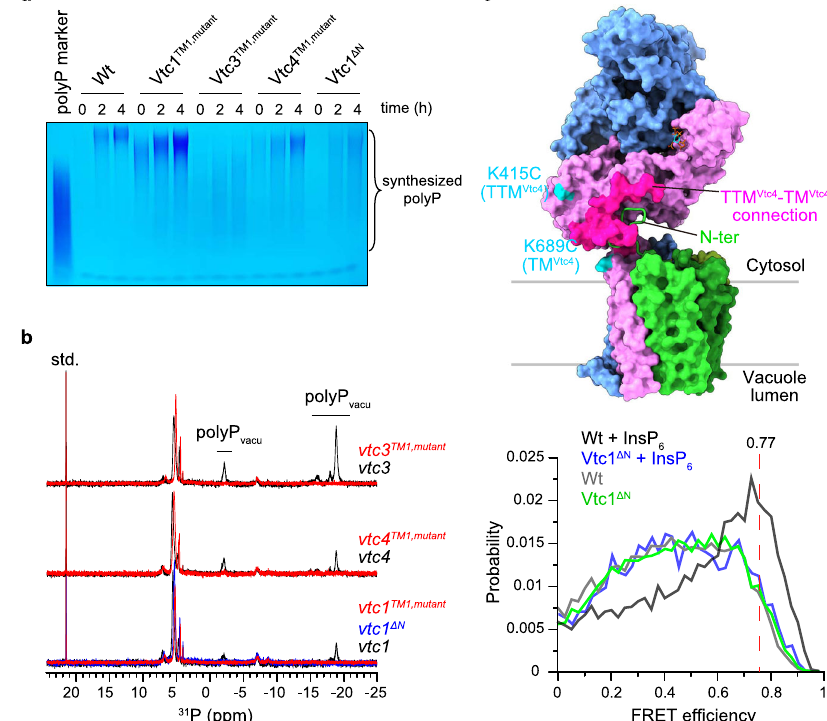
Fig. 5 | Mechanistic coupling of polyP synthesis and membrane translocation. vacuolarpolyParedenoted.MDPwasusedasthestd.reference. c smFRETanalysis a Assay of VTC-catalyzed polyP synthesis. 5 μ M protein complex were used and of VTC conformational changes. Top : Sites for fl uorophores conjugation are high- reactions were performed with required times in the presence of 1mM InsP 6 . Wt, lighted in cyan on the molecular surface representation of InsP 6 -activated VTC Vtc1/Vtc3/Vtc4; Vtc1 TM1,mutant , Vtc1 K24A/R31A /Vtc3/Vtc4; Vtc3 TM1,mutant , Vtc1/Vtc3 K694A/ complex. The connection between TTM Vtc4 and TM Vtc4 (residues 472 – 618) is Δ N ,Vtc1 Δ representedinmagentasurface.TheN-terminusofVtc1 A protomer(N-ter,residues 1 – 21 /Vtc3 K698A/R705A/R709A /Vtc4;Vtc4 TM1,mutant ,Vtc1/Vtc3/Vtc4 K622A/R629A ;Vtc1 /Vtc4. Source data are provided as a Source Data fi le. The experiments were 1 – 21)isshownincartoonrepresentation. Bottom :smFRETpro fi lesof VTCcomplex repeated three times independently with similar results. b In-cell 31 P-NMR mea- (Wt)inthe presenceand absenceof1mMInsP 6 are colored inblackandgraylines, surement of vacuolar polyP in yeast strains. vtc3 and vtc3 TM1,mutant , vtc4 and respectively. smFRET pro fi les of VTC complex carrying Vtc1 N-terminus deletion (Vtc1 Δ N ) in the presence and absence of 1mM InsP 6 are colored in blue and green vtc4 TM1,mutant , vtc1 , vtc1 TM1,mutant and Vtc1 Δ N were complemented into the vtc2 Δ vtc3 Δ , lines,respectively.ReddashedlineindicatesthepositionofFRETef fi vtc2 Δ vtc4 Δ , vtc2 Δ vtc1 Δ background strains, respectively. Chemical shifts of